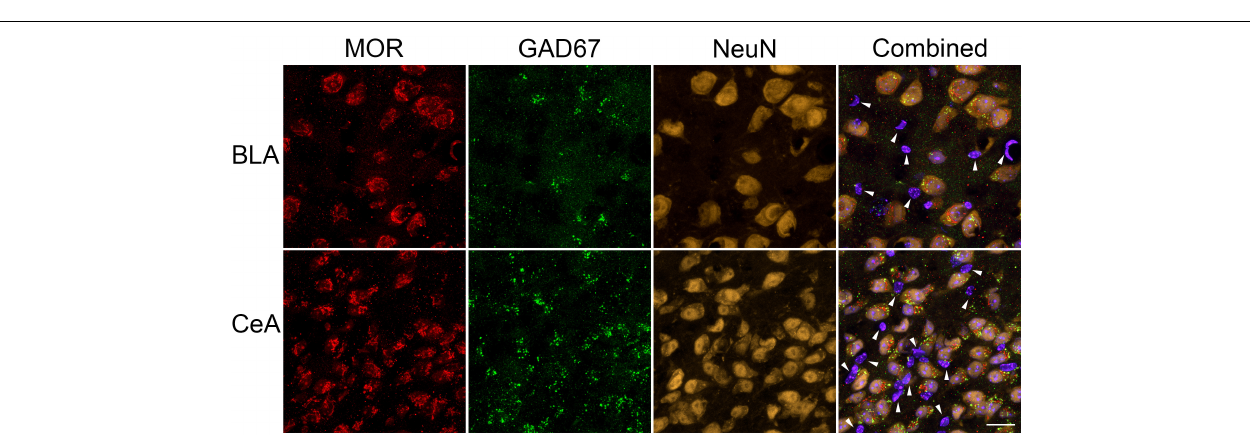
FIGURE 5 | Morphine increased amygdalar levels of the tau phospho-isotype pSer396. Representative images of amygdalar pTau (Ser396), pTau (Thr205), and total tau (A) , and neurofilament light chain (NFL) immunoblots (B) of Tat(–) and Tat(+) mice administered DOX for 8 weeks and ramping morphine (or saline) during the last 2 weeks of exposure. In both Tat(–) and Tat(+) mice given ramping morphine for 2 weeks the ratio of p-tau (Ser396) to total tau was significantly increased (A’) , while the ratio of p-tau (Thr205) to total tau tended to be elevated (albeit not significantly) (A”) . Neither Tat nor morphine altered neurofilament light chain levels in the amygdala (B’) . Data are presented as the mean ± the SEM; n = 6–7 mice per group, # p < 0.05 main effect of morphine. Morph, morphine; NFL, neurofilament light chain.